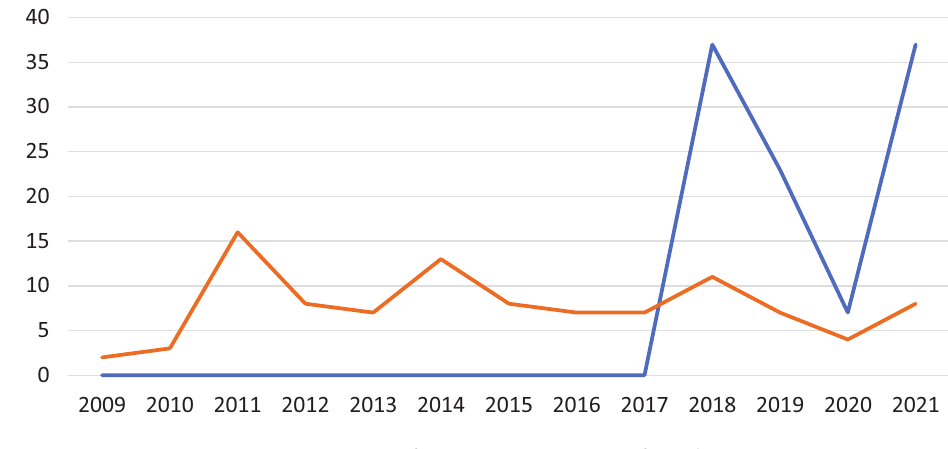
Figure 5. Number of images per articles in digital media (2009–2021). Urban Planning, 2021, Volume 6, Issue 4, Pages